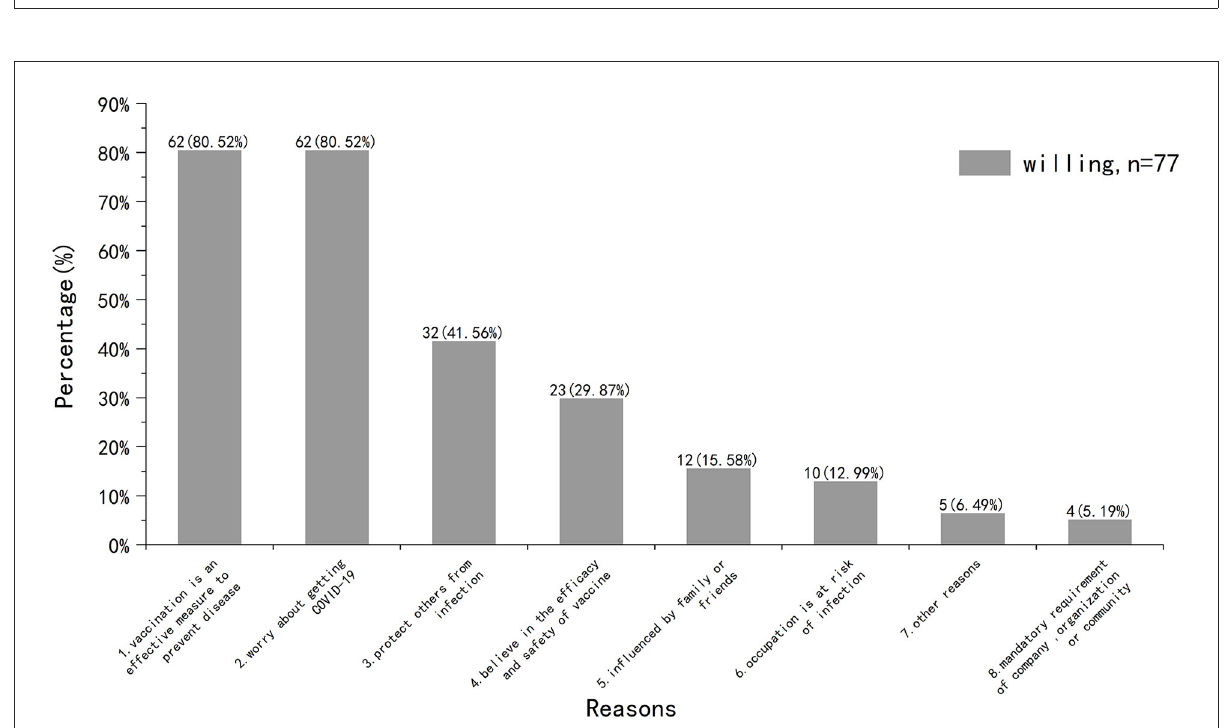
FIGURE4 Reasons for willing to get